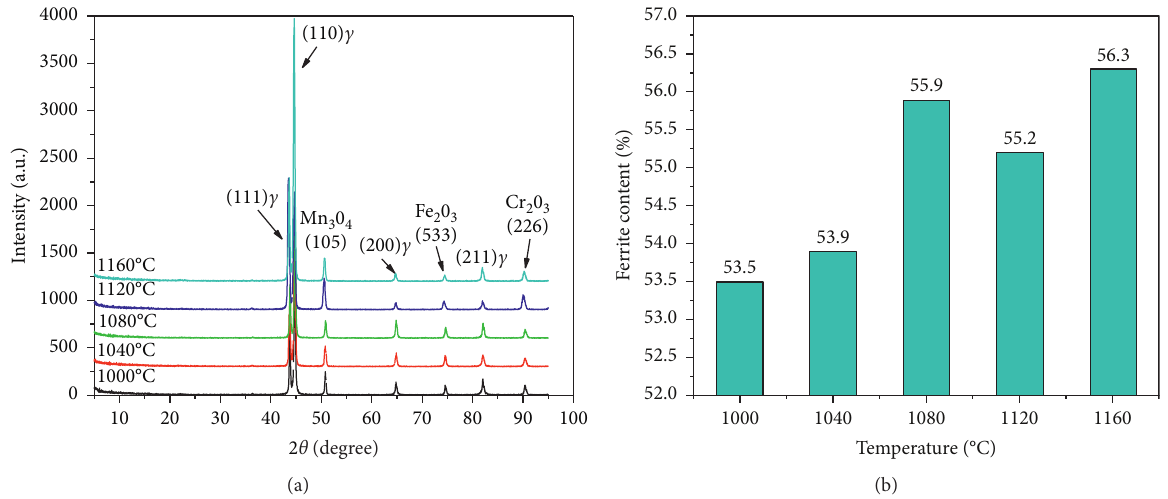
Figure 2: (a) X-ray diffraction patterns of the duplex stainless steel surface. (b) Ferrite phase proportion of 2205 duplex stainless steel at different solution